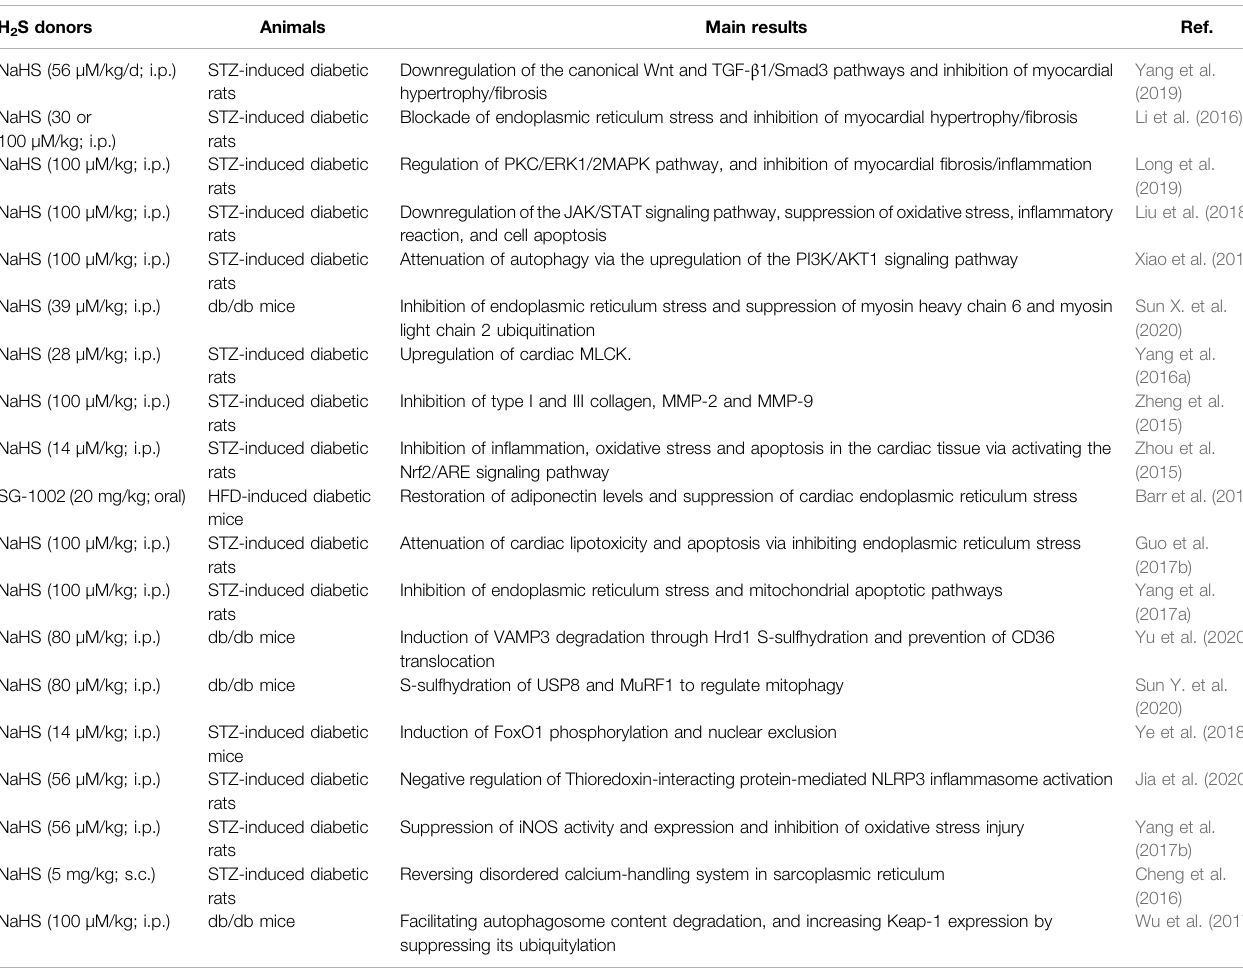
TABLE 4 | Molecular mechanisms of H 2 S donors in the treatment of diabetic cardiomyopathy at the animal level. H 2 S